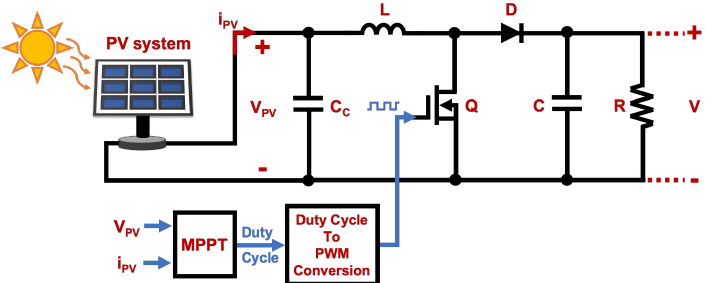
Figure 8. Selected topology for the case study.